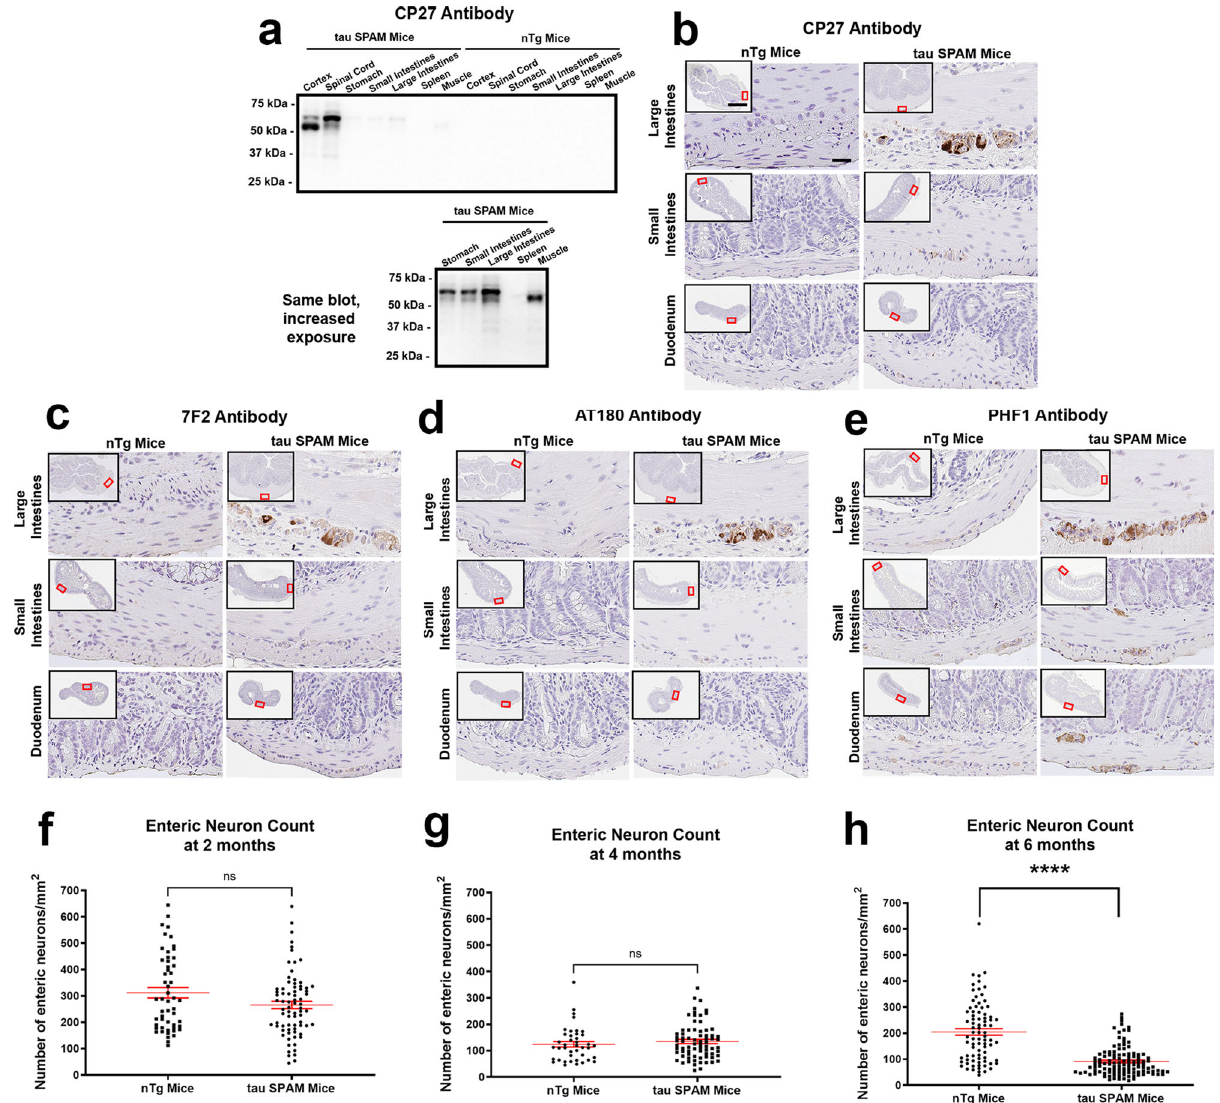
Fig. 10 Enteric neurons are vulnerable to pathogenic tau and lead to signi fi cant enteric neuron loss in tau SPAM mice. a Immunoblot of lysates from different organs as indicated above each lane with antibody CP27 comparing expression in tau SPAM mice and nTg mice show that intestinal expression is very low relative to brain and spinal cord expression levels. 10 μ g of protein was loaded per lane. Longer exposure of membrane (below) with only the lanes, including stomach, small intestines, large intestines, spleen, and muscle shows that most of the tau is shifted to relatively higher molecular mass band corresponding to hyperphosphorylated tau. The relative molecular mass markers are shown on the left. b CP27 immunostaining of duodenum, small intestines, and large intestines shows that human tau is more highly expressed in the large intestines. Scale bar = 50 μ m for main image and 1 mm for inset. c Tau phosphorylation at Thr205 labeled with antibody 7F2 and ( d ) at Thr231 labeled with antibody AT180 is found primarily in large intestines of tau SPAM mice and not in nTg mice. e Increased PHF1 staining (against tau phosphorylated Ser396/Ser404) is found throughout the intestinal tract, particularly the large intestines of tau SPAM mice. f Random intestinal slides were sampled throughout the intestinal tract and stained with H&E for estimation of total enteric neurons. At 2 months, there was no statistically signi fi cant difference in enteric neuron density between tau SPAM mice and nTg mice (two-tailed t -test, t = 0.8162, df = 112, p = 0.4161) for N = 73 sections for tau SPAM mice and N = 41 sections for nTg mice. ns not statistically signi fi cant. g At 4 months, there was no statistically signi fi cant difference in enteric neuron density between tau SPAM mice and nTg mice (two-tailed t - test, t = 1.976, df = 127, p = 0.0503) for N = 76 sections in tau SPAM mice and N = 53 sections in nTg mice. ns not statistically signi fi cant. h At 6 months, tau SPAM mice had signi fi cant neuronal loss (~55% loss of neurons) compared with nTg mice (two-tailed t -test, t = 9.172, df = 195, p < 0.0001) for N = 115 sections in tau SPAM mice and N = 82 sections in nTg mice. Error bars represent standard errors of the mean. **** p <